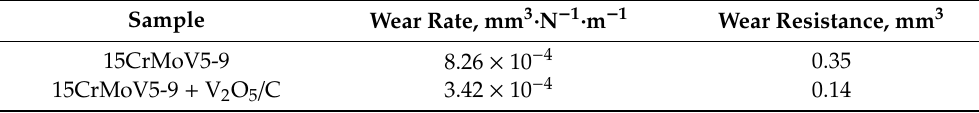
Figure 7. Microhardness of the matrix without coating, coated with V 2 O 5, and V 2 O 5 / C. The wear resistance of the initial sample was 0.35 mm 3 , and for the sample with a double-layer coating, this was 0.14 mm 3 (Table 1, Figure 8). Table 1. Characteristics of the wear resistance of the sample.